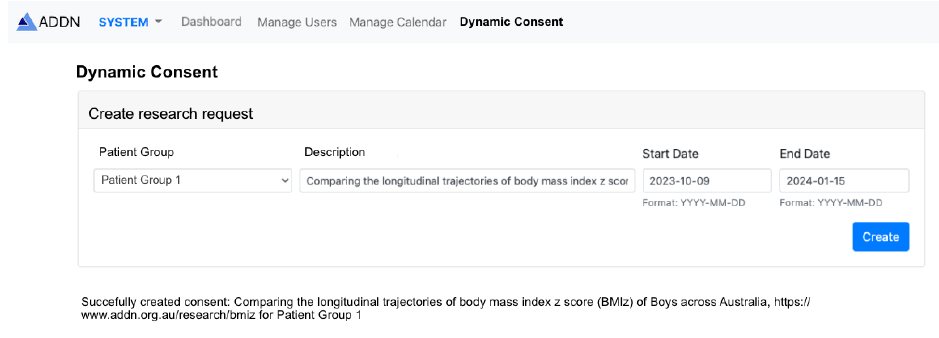
Figure 3. Screenshots of the ADDN registry: creating a research request. Figure 3 . Screenshots of the ADDN registry: creating a research request .